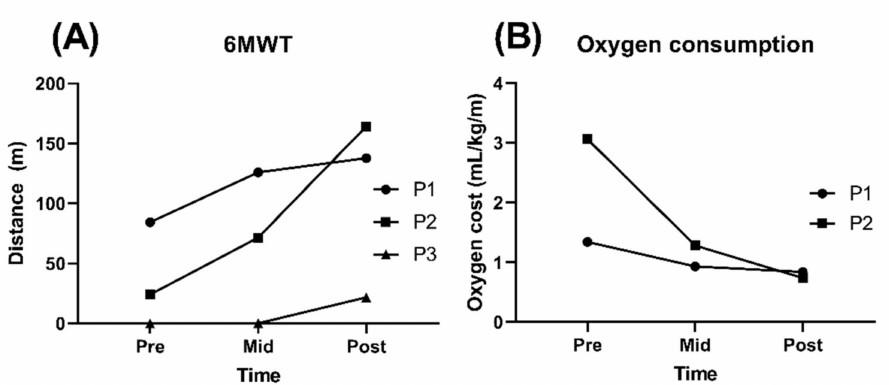
Figure 2. Changes in the 6-min walking test (6MWT) ( A ) and oxygen consumption ( B ) in children with CP through before, after 8 sessions, and at the end of robot-assisted gait training (RAGT). In the 6MWT, participant P1 walked with no device, participant P2 walked with bilateral crutches, and participant P3 used a platform walker. The oxygen cost was measured during the 6MWT. Participant P3 did not perform the oxygen consumption test due to complaints of discomfort with the mask while